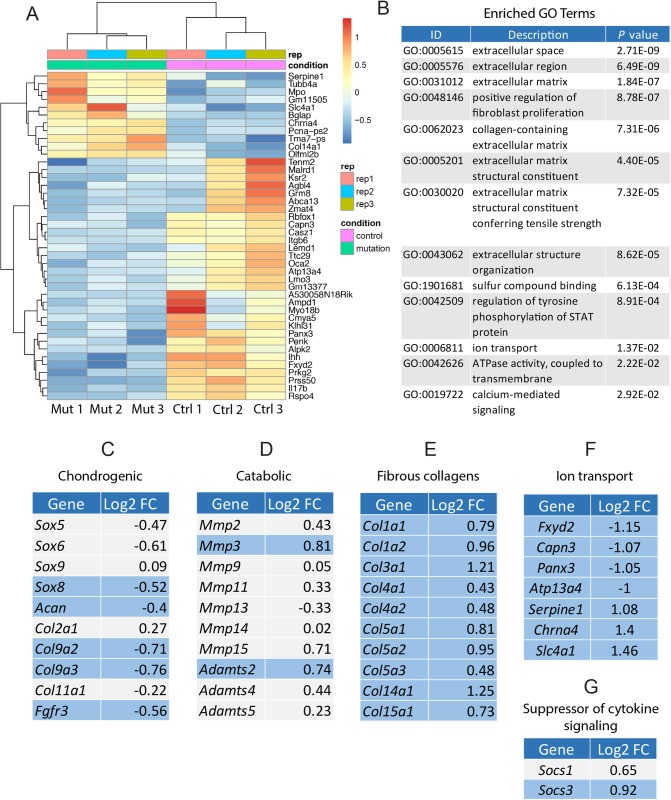
Young Col2Cre;Adgrg6f/f mutant mice display fibrotic-like changes of gene expression and dysregulation of genes associated with ion transport in the IVD.(A) Heatmap of differentially expressed gene based on RNA-sequencing analysis of IVDs derived from both Col2Cre;Adgrg6f/f mutant (Mut 1–3) and Cre (-) littermates (Ctrl 1–3) at P20. (B) Gene ontology (GO) analysis revealed a suite of differentially expressed genes important for extracellular matrix organization and ion transport. (C-G) RNA-sequencing analysis revealed mild alterations in some chondrogenic (C) and catabolic (D) gene expression, but significantly induced fibrotic gene expression (E) and dysregulation of genes involved in ion transport (F) in the Col2Cre;Adgrg6f/f mutant IVDs at P20. Some genes encode members of the suppressor of cytokine signaling were also upregulated in the mutant IVDs (G). Differential expressed genes with p value < 0.05 were highlighted in blue. Log2FC: gene expression fold changes in Log2 scale.